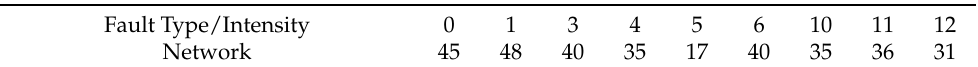
Table 1. Correspondence between the type of failure including the intensity values with the best response for the production of